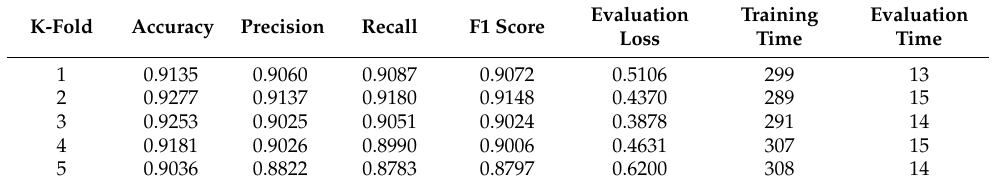
Table 15. DistilBERTimbau—TCIE